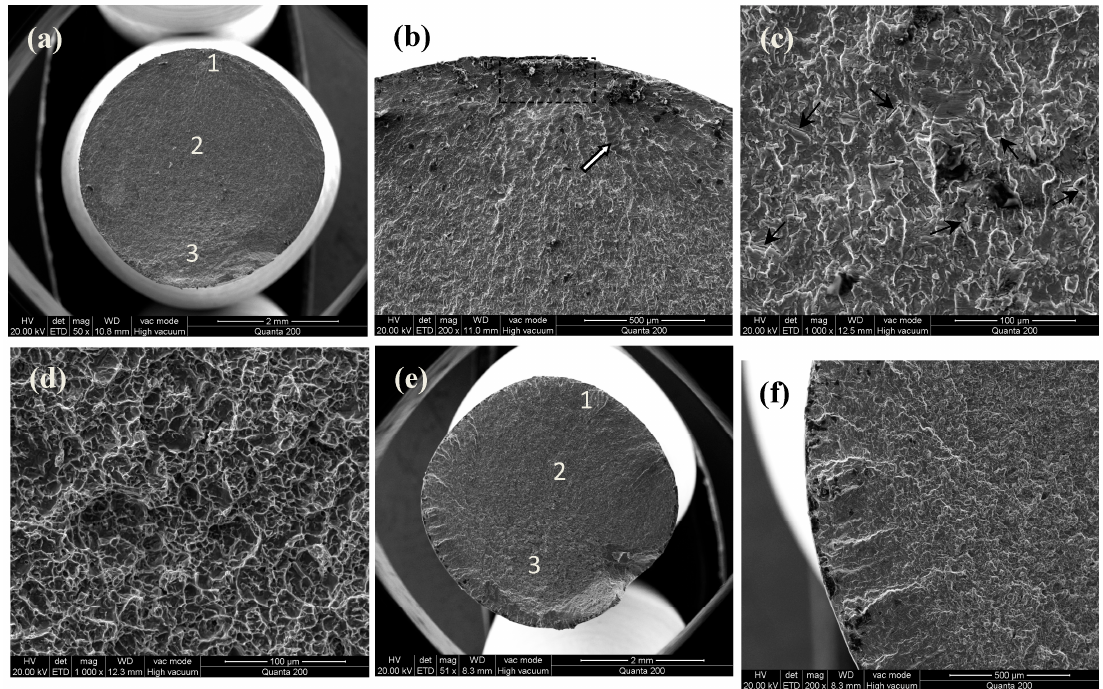
Figure 12. Fatigue fracture surfaces of untreated specimen at different stresses: ( a ) fracture surface at 450 MPa; ( b ) area “1” 200×; ( c ) local amplification of area “2”; ( d ) local amplification of area “3”; ( e ) fracture surface at 700 MPa; ( f ) cleavage striations in material surface layer.